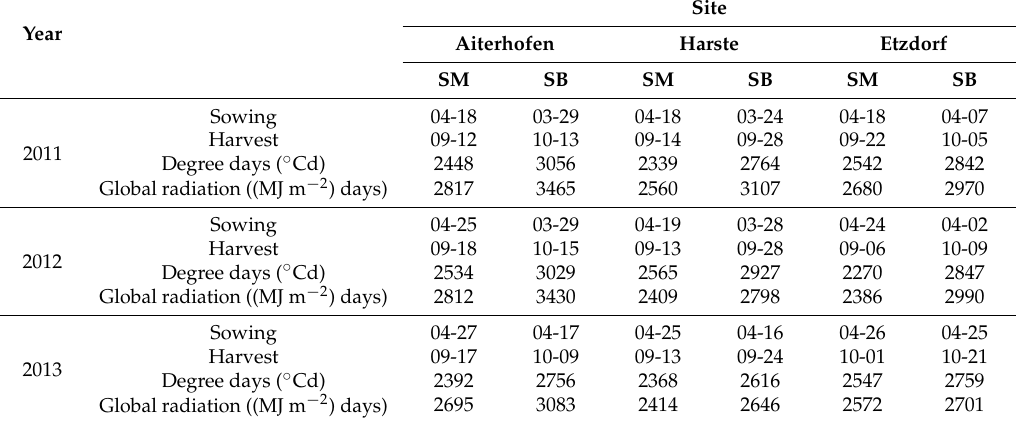
Table 2. Sowing and harvest dates as well as degree days and sums of global radiation for the cultivation of biomass crops, silage maize (SM) and sugar beet (SB), at three experimental sites in Germany